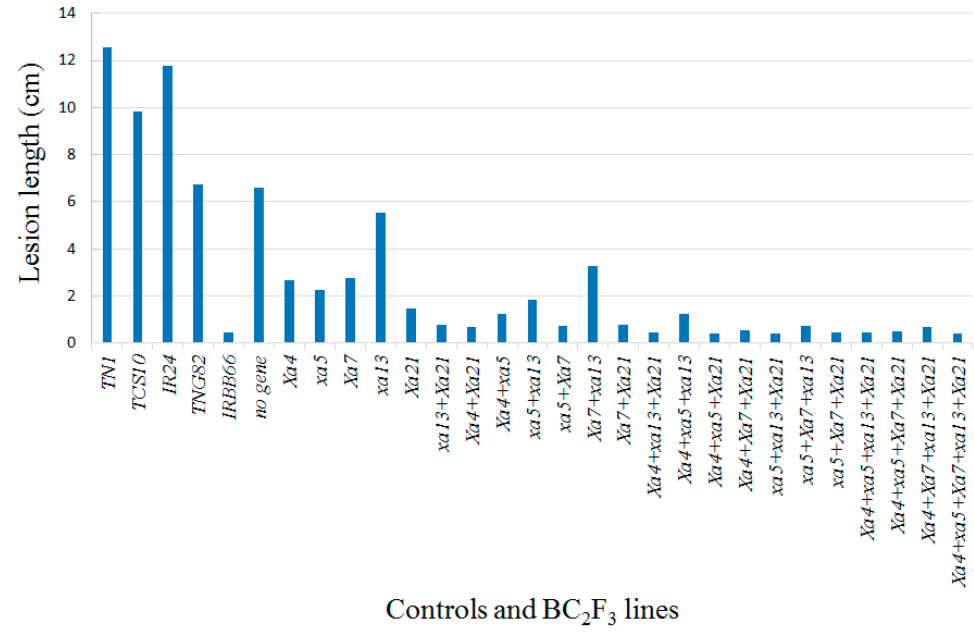
Figure 4. The leaf lesion length of TNG82/IRBB66 BC 2 F 3 genotypes after 21 days inoculum of bacterial blight pathogen XF89-b in the field at the first crop season in 2016. Susceptible cultivar: TCS10, IR24, and TN1; Parental: TNG82 and IRBB66.